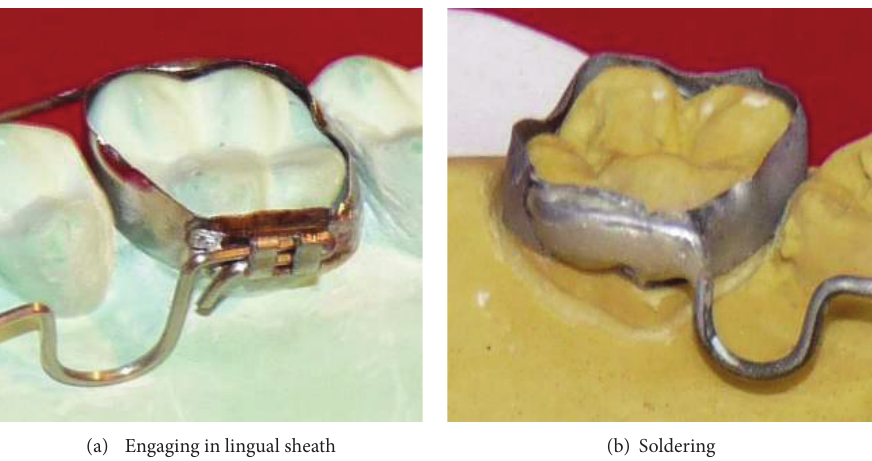
Figure 2: Appliance secured to molar band by (a) engaging in lingual sheath and (b) soldering.